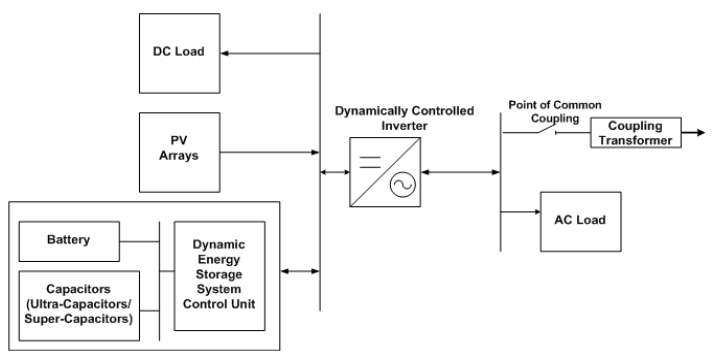
Figure 11. Block diagram of the integration of